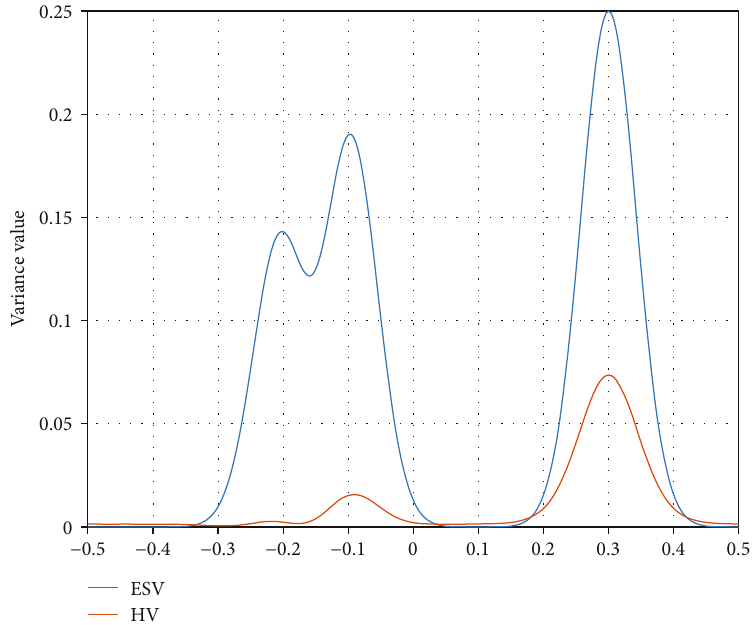
Figure 3: Comparison of the numerical values of the original target ESV and